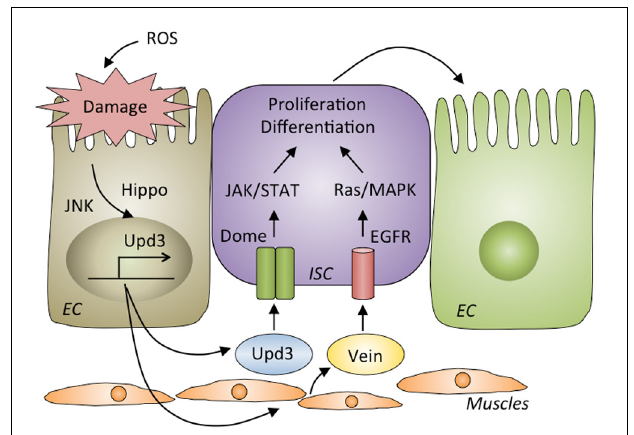
FIGURE 4 | Gut repair after damage by infection. Reactive oxygen species (ROS) produced by host cells destroy the gut epithelia. The JNK and Hippo pathways are activated in damaged enterocytes, where they produce Upd3, a ligand for Domeless (Dome) that activates the JAK/STAT pathway in intestinal stem cells (ISCs) to proliferate and differentiate into enterocytes (ECs). Upd3 also triggers the production of Vein in muscle cells that activates EGFR/Ras/MAPK pathway in ISCs to promote their proliferation and